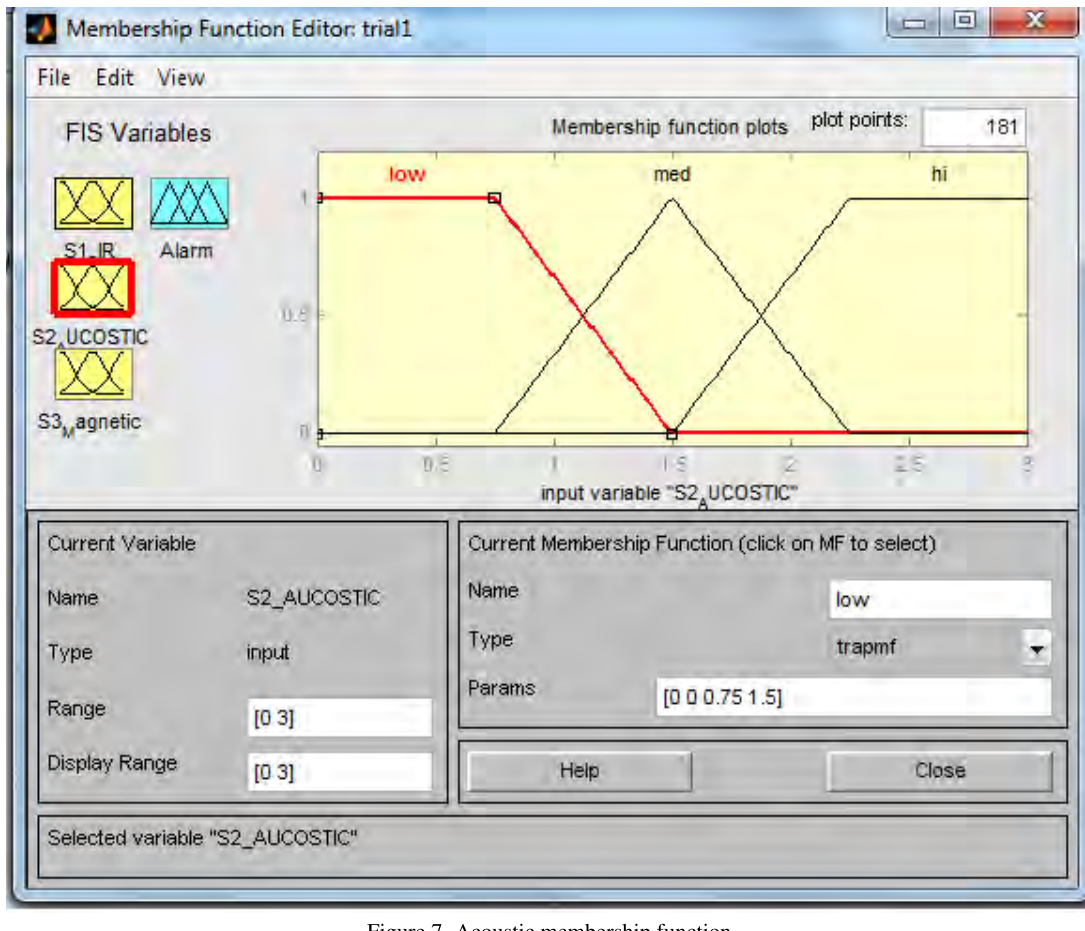
Figure 7. Acoustic membership function